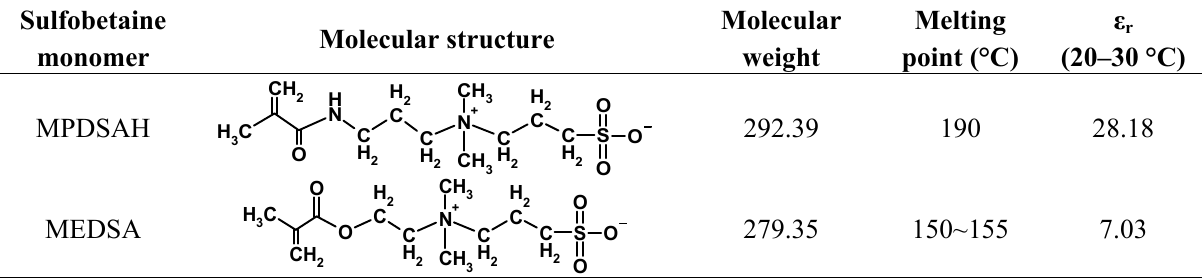
Table 2. Properties of MPDSAH and